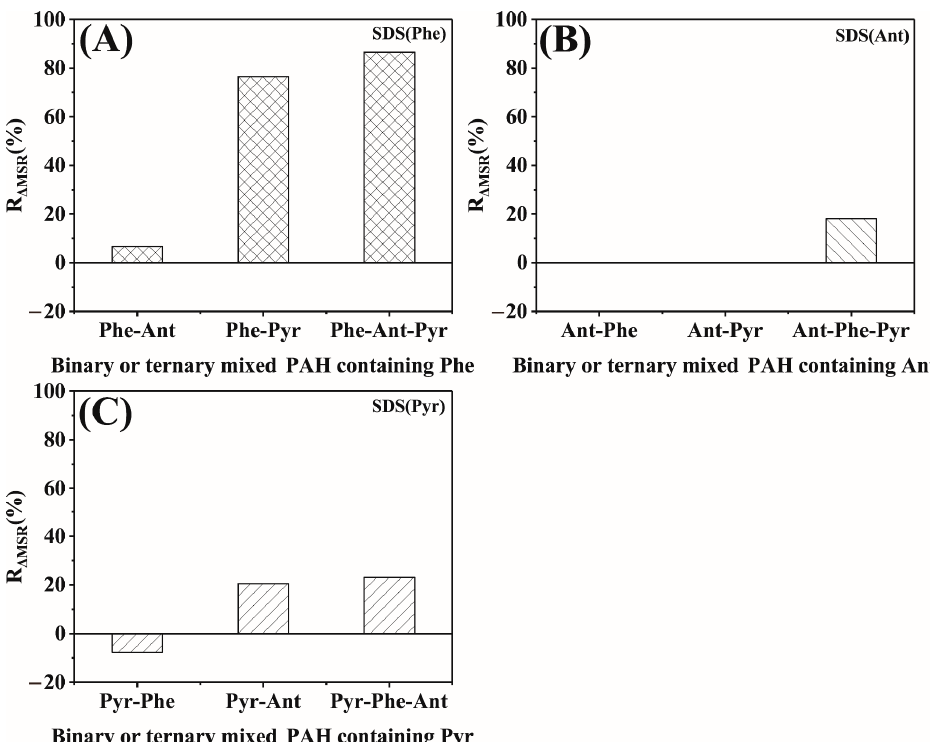
Figure 8. R Δ MSR of Phe ( A ), Ant ( B ) and Pyr ( C ) in binary and ternary co ‐ solubilization systems in Figure 8. R ∆ MSR of Phe ( A ), Ant ( B ) and Pyr ( C ) in binary and ternary co-solubilization systems in SDS micellar solutions. SDS micellar solutions.